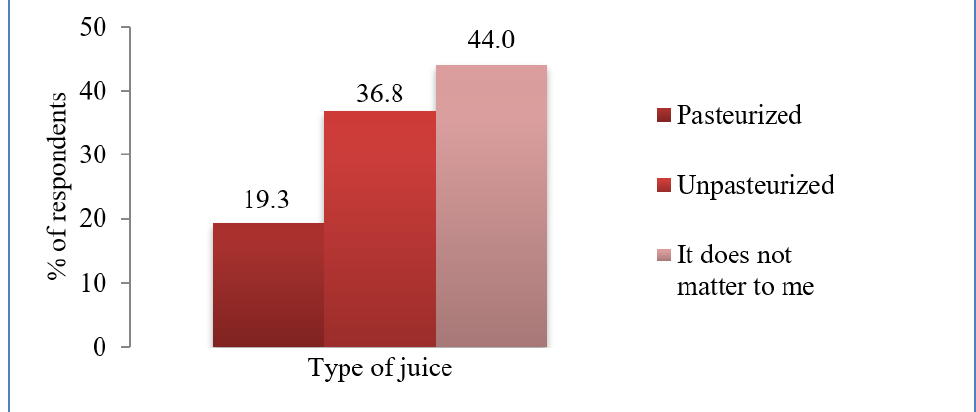
Figure 7. Selection of citrus juices due to the form of preparation (fixation) of the